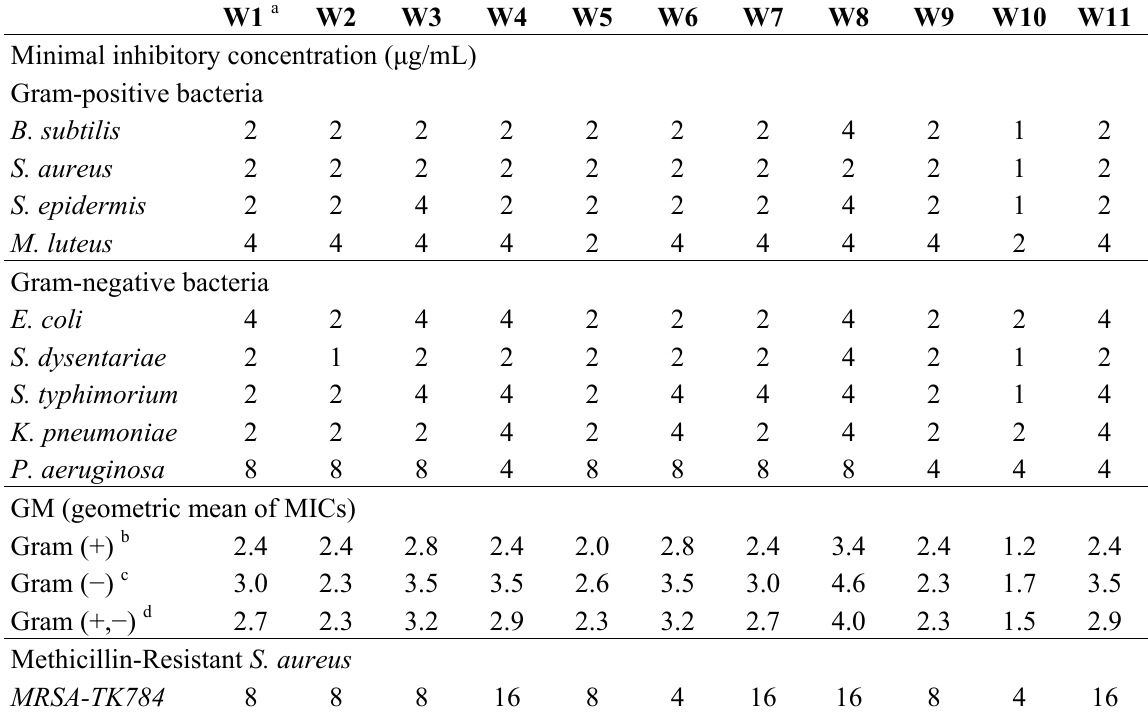
K W n model 5 5